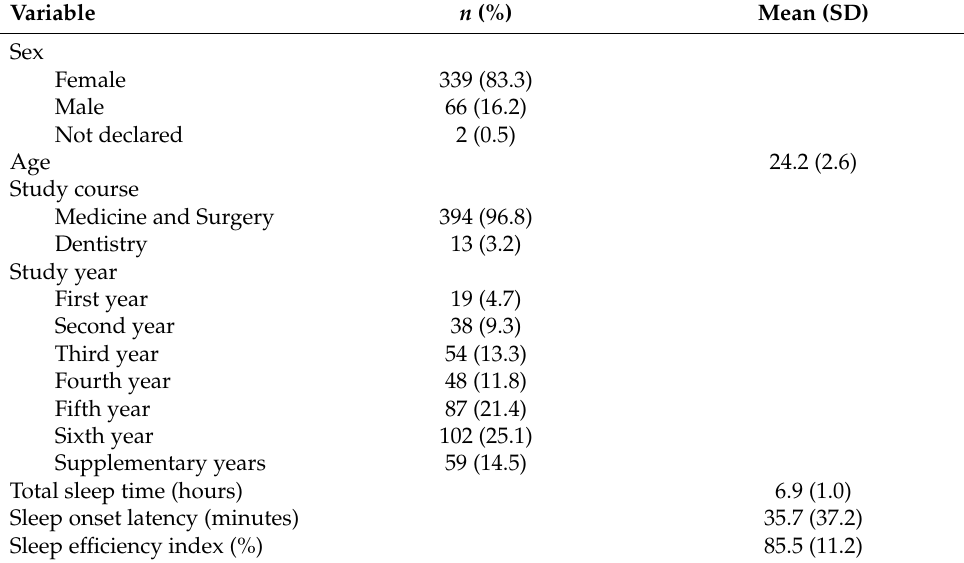
Table 1. Participants’ ( n = 407) socio-demographic and sleep characteristics.